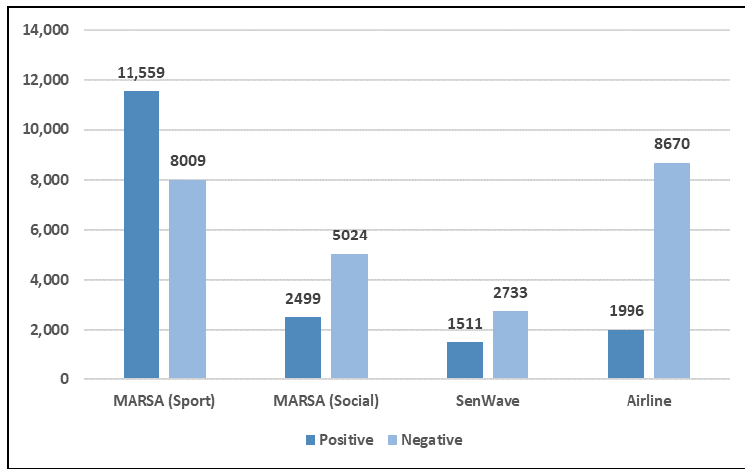
Figure 3. The number of tweets in each class for all the datasets used. Table 7. Distribution of samples among training and test